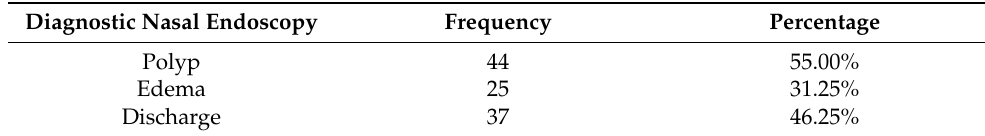
Table 3. Diagnostic nasal endoscopy of study subjects.